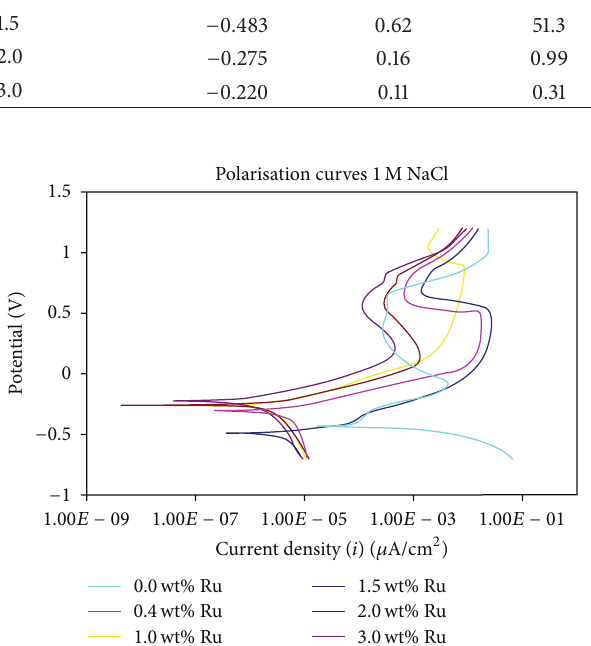
Figure 2: Comparative behavior of WC-Co in 1M NaCl with increasing additions of Ru.